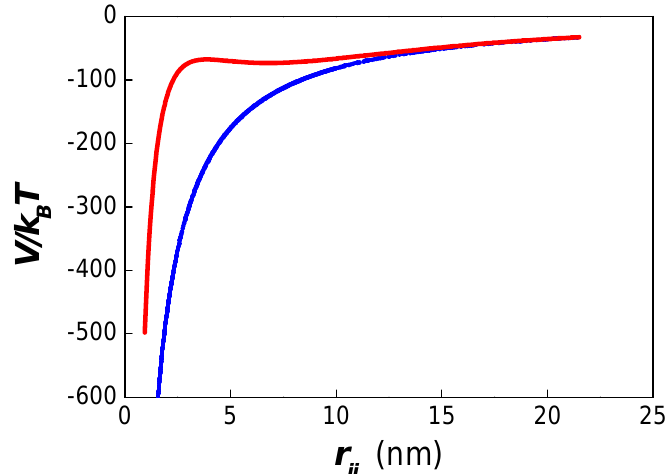
Figure 6. DLVO potential (red line) between two spherical drops of bitumen ( R μ m) with a surface charge of σ = 13.95 mCoul/m 2 ( Ψ ionic strength of the solution is equal to 1.4 x 10 -2 M. The van der Waals potential is shown in blue.